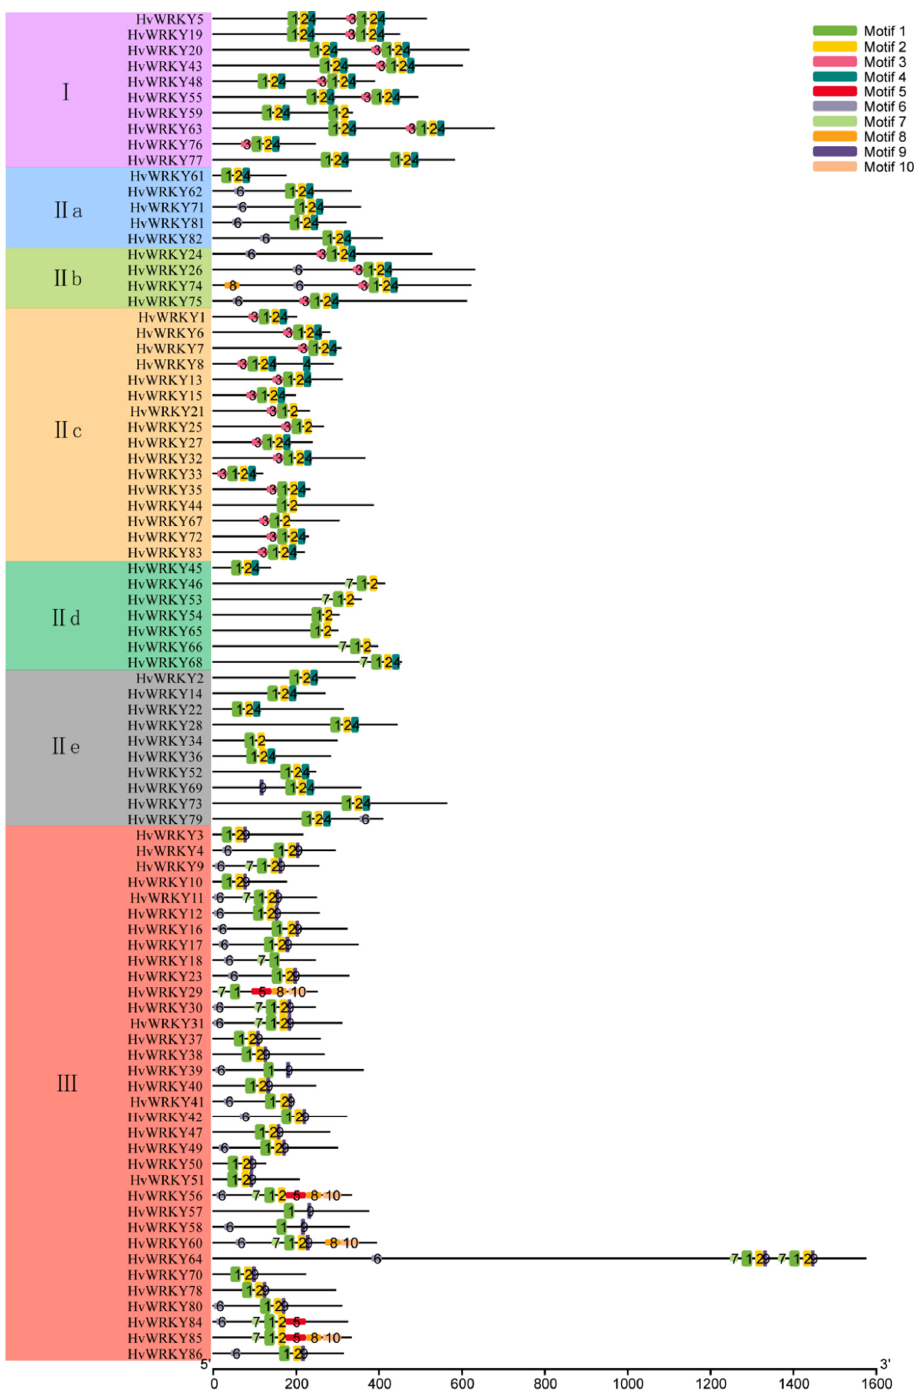
Figure 5. Distribution of conserved motifs of HvWRKY protein in each group. Ten motifs were predicted by MEME and are shown in different colors. Motifs 1/2/4/9 were all located in the WRKY domain and represented by a wider rectangle. Gene structure analysis showed that most HvWRKYs had at least one intron, and the number of exons ranged from two to seven, except for seven genes ( HvWRKY1 / 9 / 10 / 11 / 12 / 16 / 54 ) (Figure 6). A HvWRKY gene with three exons was the most frequent type, account- ing for 47.7% of the total. The statistical results of the number of introns in each group showed that the genes encoding group I and subgroup II b proteins had the most introns (Figure